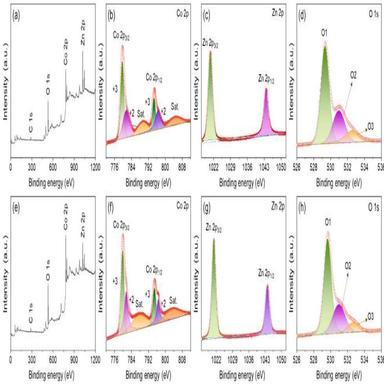
(a) XPS spectrum of ZnCo2O4 NSs, and the related high-resolution spectra of (b) Co 2p, (c) Zn 2p, and (d) O 1s; (e) the XPS survey spectrum of ZnCo2O4 NWs, and the corresponding core-level spectra of (f) Co 2p, (g) Zn 2p, and (h) O 1s.